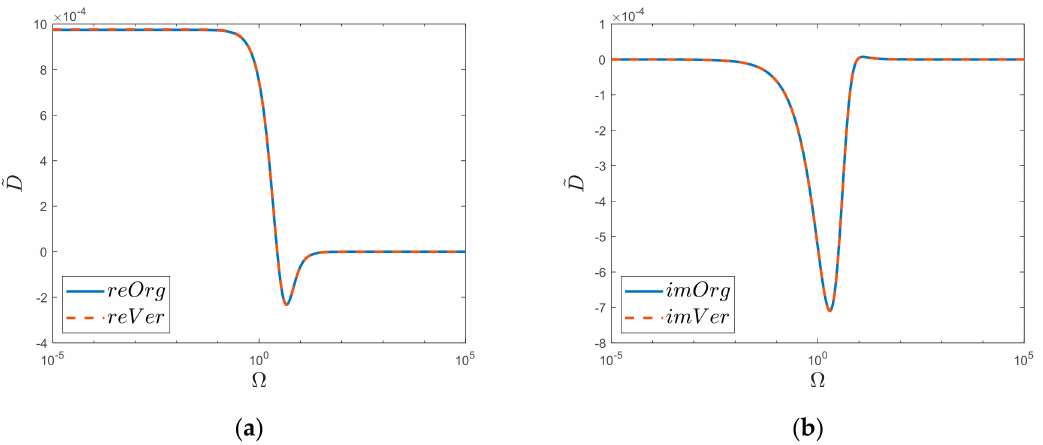
Figure 8. Realis ( a ) and Imaginaris ( b ) graphs of original function “ Org ” and newly derived substitute “ Ver ”. Semi − log scale for k = 5